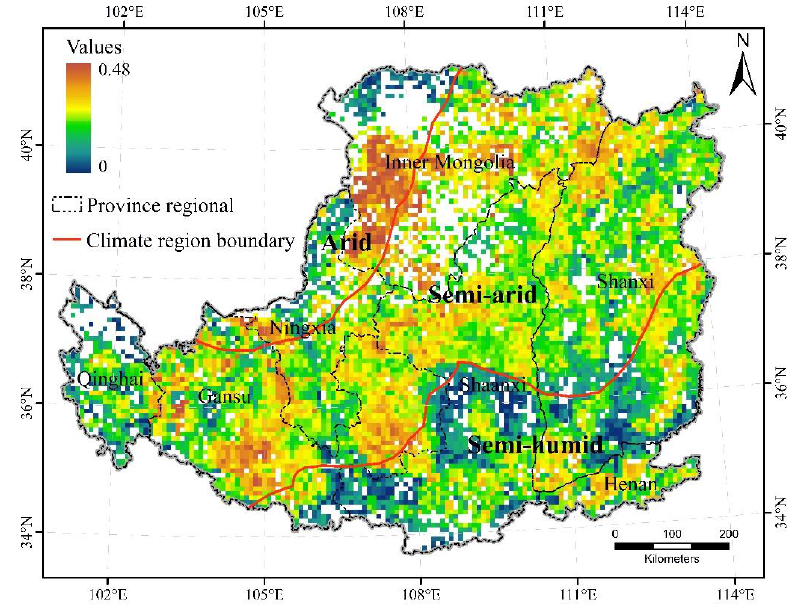
Figure 2. Spatial distributions of DRC (Drought Resistance Coefficient) of vegetation during 1982 – 2015 over the LP. Where values are larger, vegetation has lower resistance to drought; where values are smaller, vegetation has larger resistance to drought.